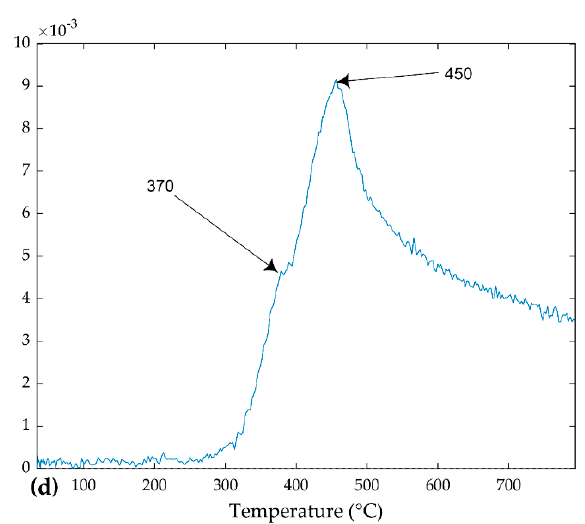
Figure 6. Loadings of the PARAFAC model. ( a ) Mode 2 loadings of component 1 (TGIS), ( b ) mode 2 loadings of component 1 (TGO), ( c ) mode 3 loadings of component 1 (TGIS), and ( d ) mode 3 loadings of component 1 (TGO). Y-values are scaled values of the components. The red circle in ( a ) shows a peak that is not seen in ( b ).